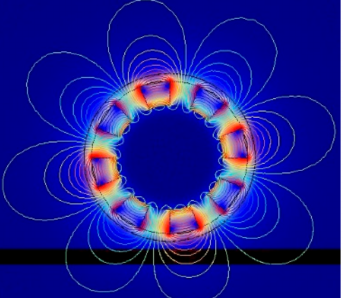
Figure 4. Magnetic wheel with Halbach-Array.